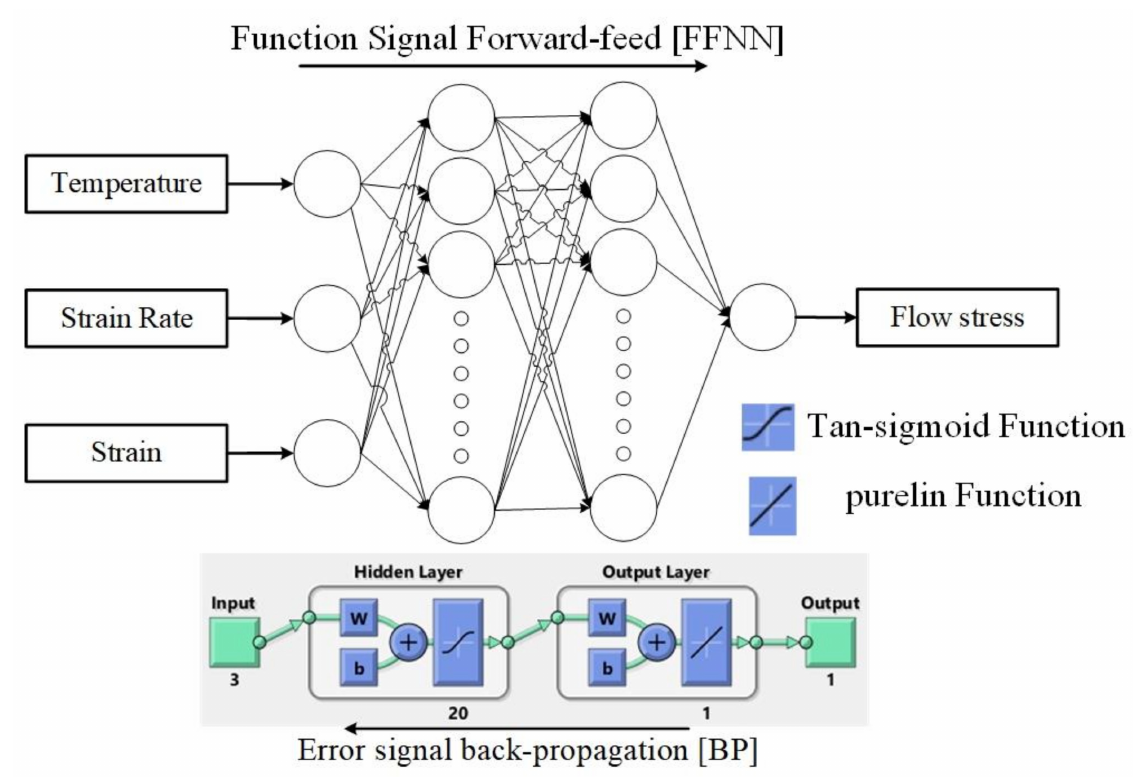
Figure 8. Artificial neural network (ANN) architecture schematic illustration for the used network. With one neuron in the hidden layer, the trial-and-error process was initiated and further executed with more neurons. A suitable number of hidden layers should